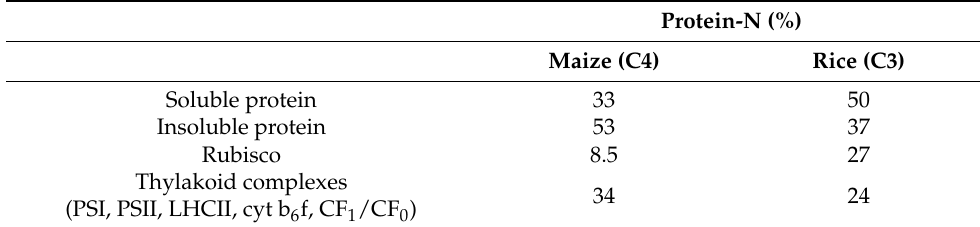
Table 1. Allocation of protein-N in young leaves of maize and rice